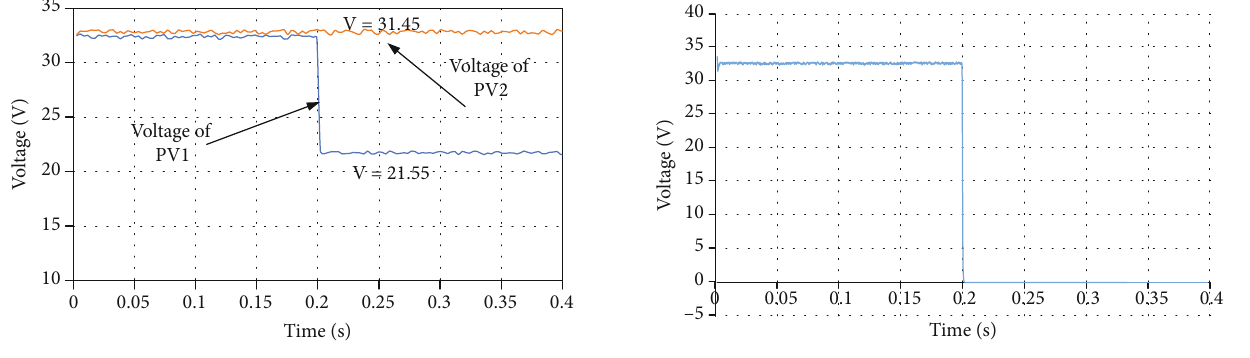
Figure 44: The output voltage of PV1 and PV2, while one of the PV1 panels ’ is failed.